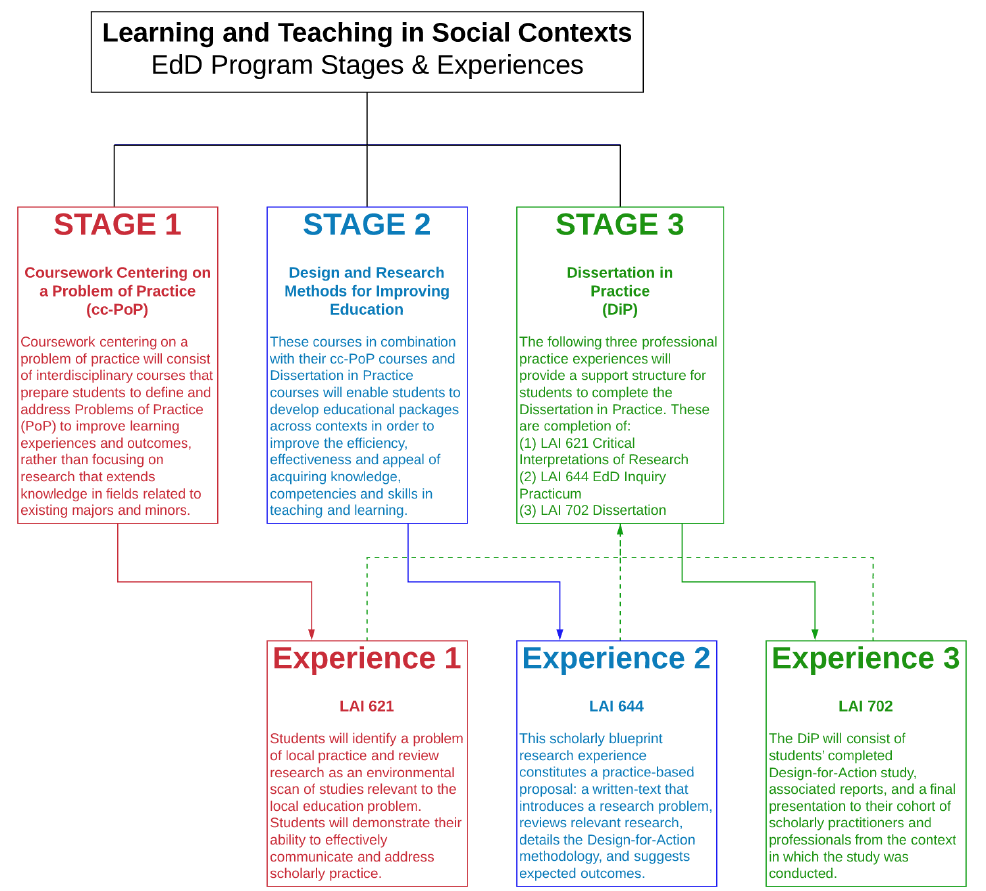
Figure 1. Cross-Cutting Program Stages and